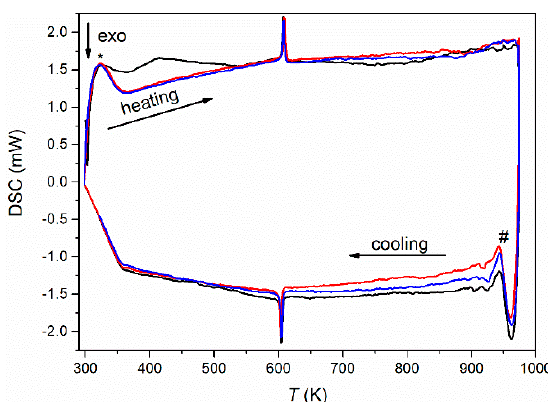
Figure 2. Differential scanning calorimetry (DSC) measurements (first cycle: black; second cycle: red; third cycle: blue) of Eu 0.8 Ca 0.2 TiO 3– δ in reducing atmosphere (5 vol% H 2 in Ar) at a heating and cooling rate of 5 K·min ⁻ 1 . The * denotes artefacts from nonlinear heating, and # denotes artefacts by switching from heating to cooling.